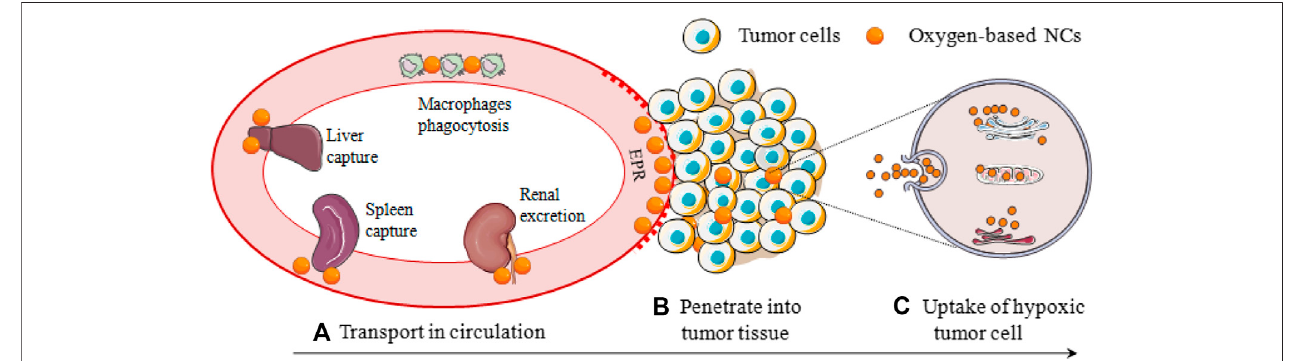
FIGURE 5 | Hypoxic tumor cells oxygen-based NCs delivery process, involving (A) Transport in circulation; (B) Penetrate into tumor tissue; and (C) Uptake of hypoxic tumor cell.